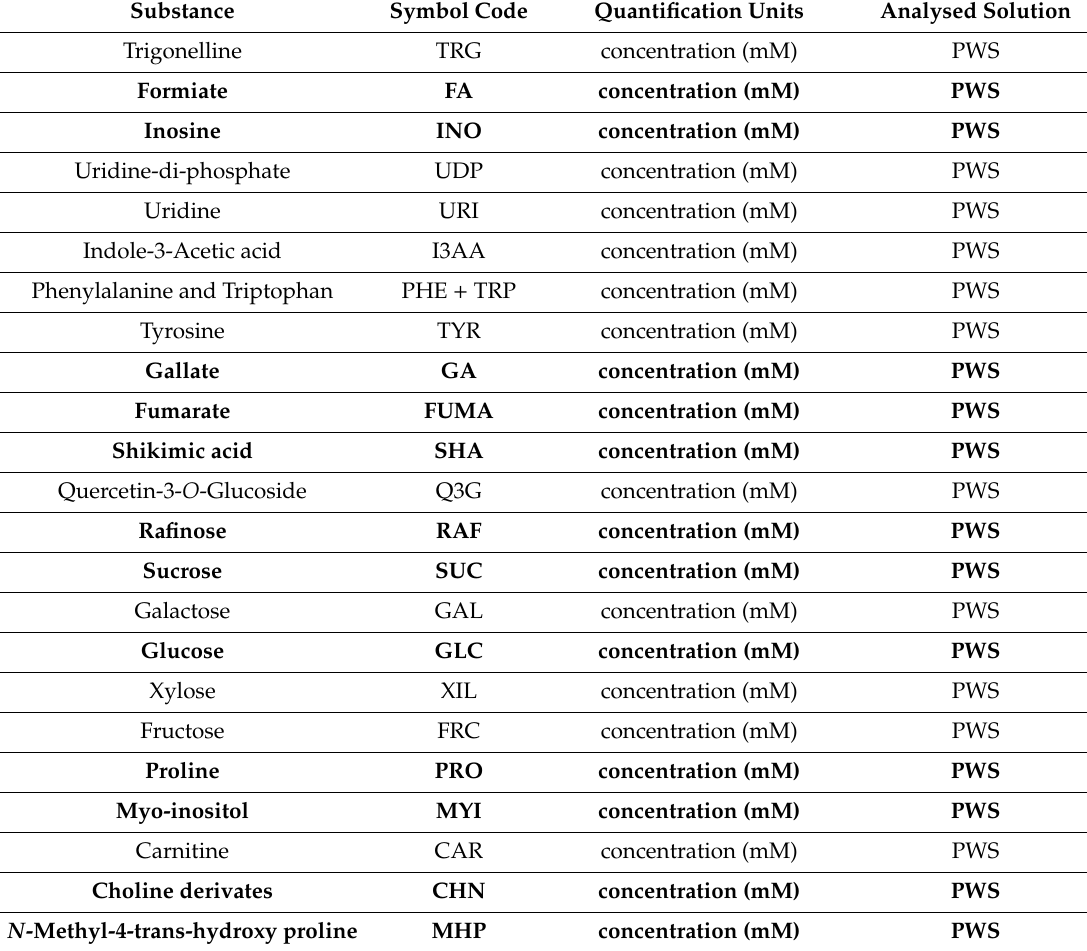
Table A1. Detailed list of compounds contained in pistachio seeds which were detected and quantified by NMR either in the PWS or in PO, along with the quantification units and labels for each variable. Variables in bold were used for the principal component